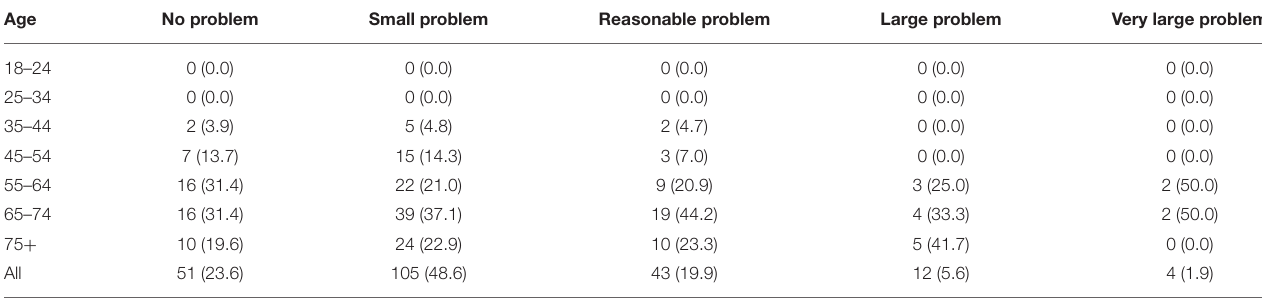
TABLE 5 | Answers to the question: How big a problem is your tinnitus at this moment? of pathologic tinnitus participants.